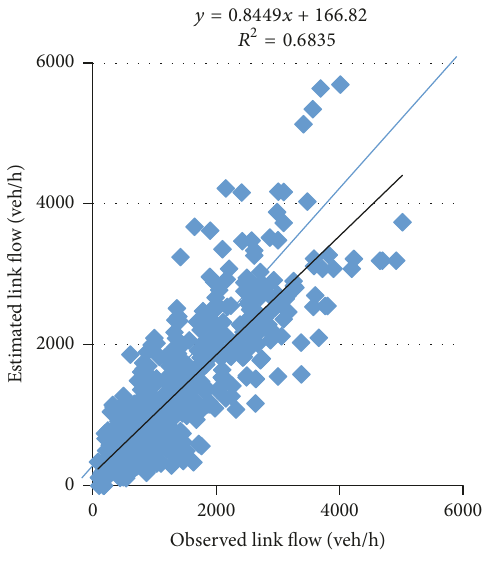
Figure 7: Result of TCoE at